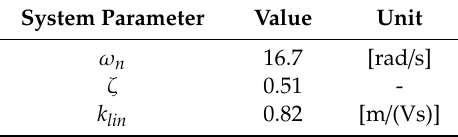
Table 2. Identified system parameters.